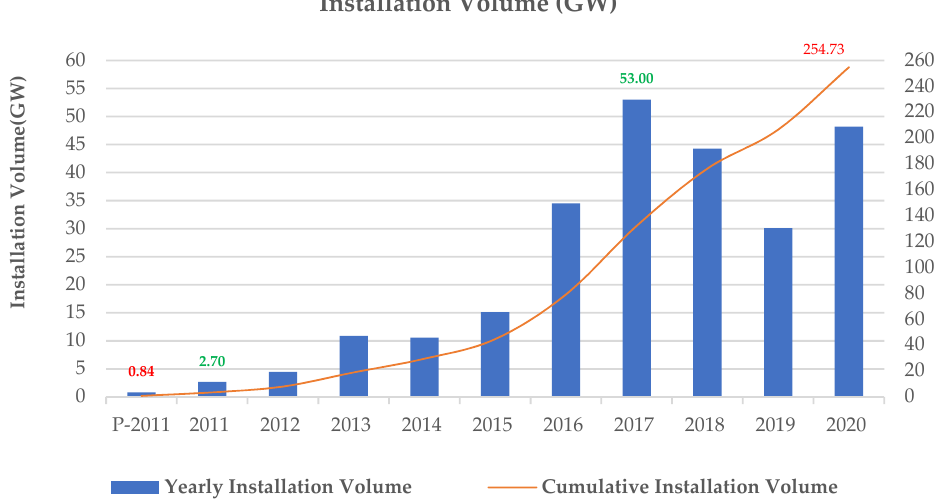
Figure 13. Yearly and cumulative installation volume (2011–2020). Source: CPIA [66] and organized by the authors.